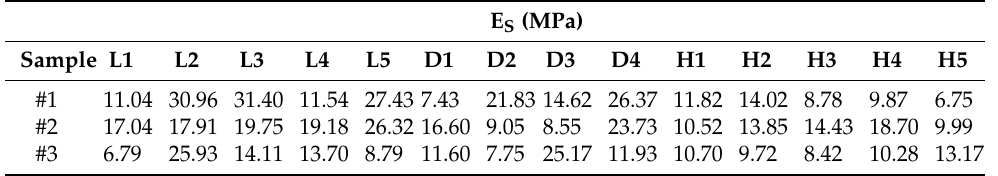
Figure 4. Results of tensile tests for PF of subjects with Ledderhose disease ( a ), diabetes ( b ) and healthy subjects ( c ). The results are reported in terms of nominal stress P (mean values ± SE) vs. nominal strain ε . Table 2. Secant modulus E S of different PF samples for each subject at 8% strain from experimental results of tensile tests.